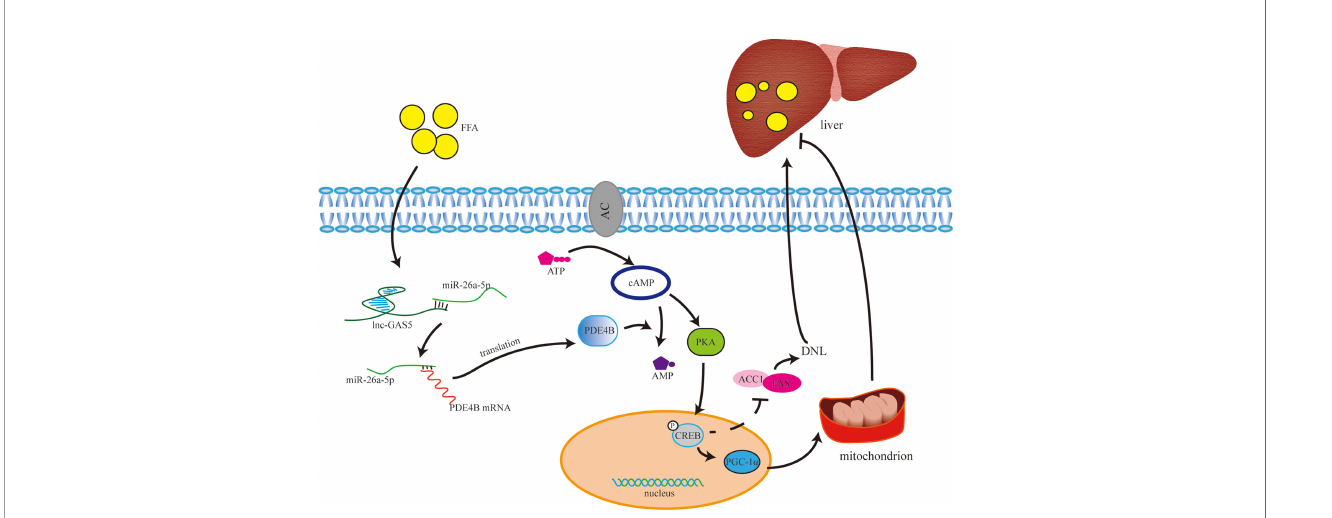
FIGURE 8 | The underlying mechanism of long non-coding RNA growth arrest speci fi c 5 (GAS5) in regulating lipid metabolism. Under normal physiological conditions, cAMP is synthesised from ATP with the catalysis of adenylate cyclase. cAMP activates PKA to phosphorylate CREB, and phosphorylated CREB (p-CREB) upregulates PGC-1 a and downregulates ACC1 and FAS expression. Therefore, through controlling the de novo lipogenesis (DNL) and mitochondrial function, high level of cAMP may reduce lipid accumulation in liver. cAMP is hydrolysed into AMP by phosphodiesterase, especially phosphodiesterase-4B in liver. GAS5 is upregulated in hepatocytes with high-fat treatment via the miR-26a-5p/PDE4B axis, which consumes cAMP, thereby promoting fat accumulation in the